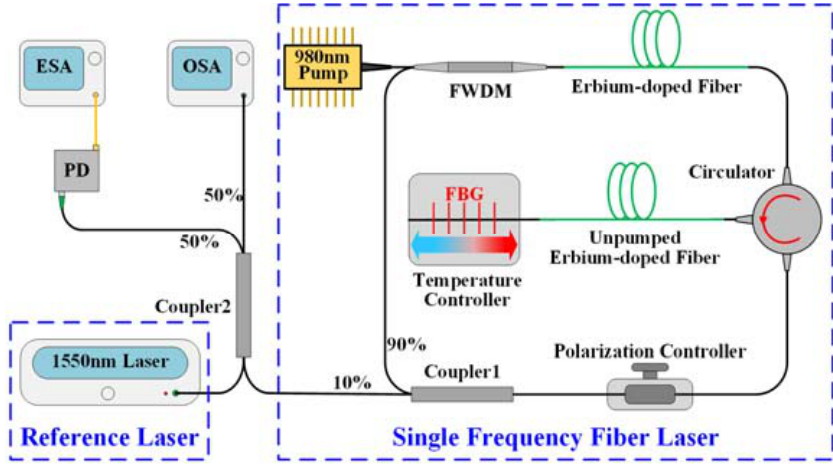
Figure 1. Experimental setup of the temperature sensor.